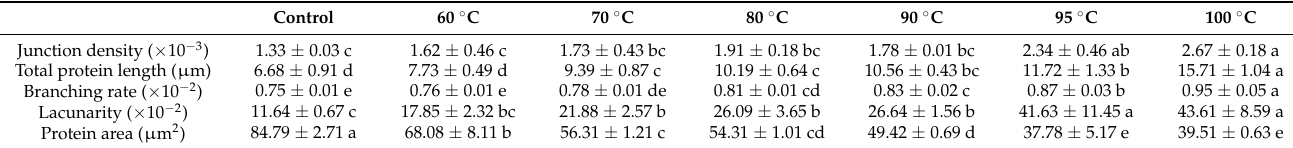
Table 1. Image analysis of CLSM of wheat protein in dough of different heating treatments.